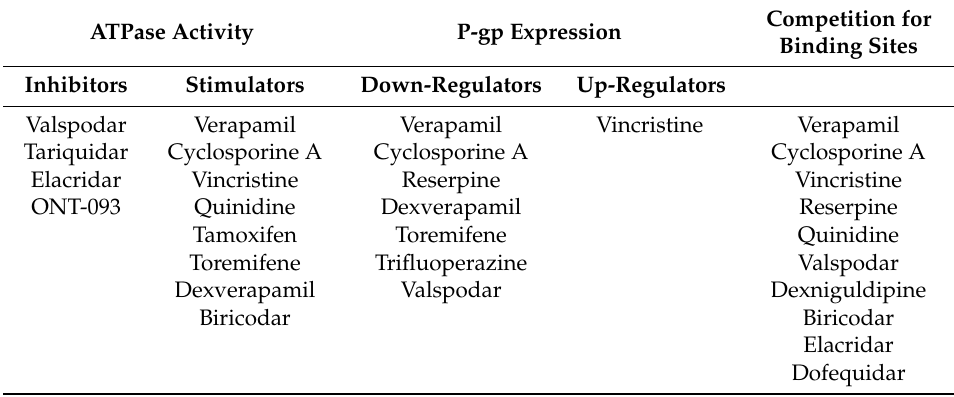
Table 2. Mechanisms of classical P-gp inhibitors. ATPase Activity P-gp Expression